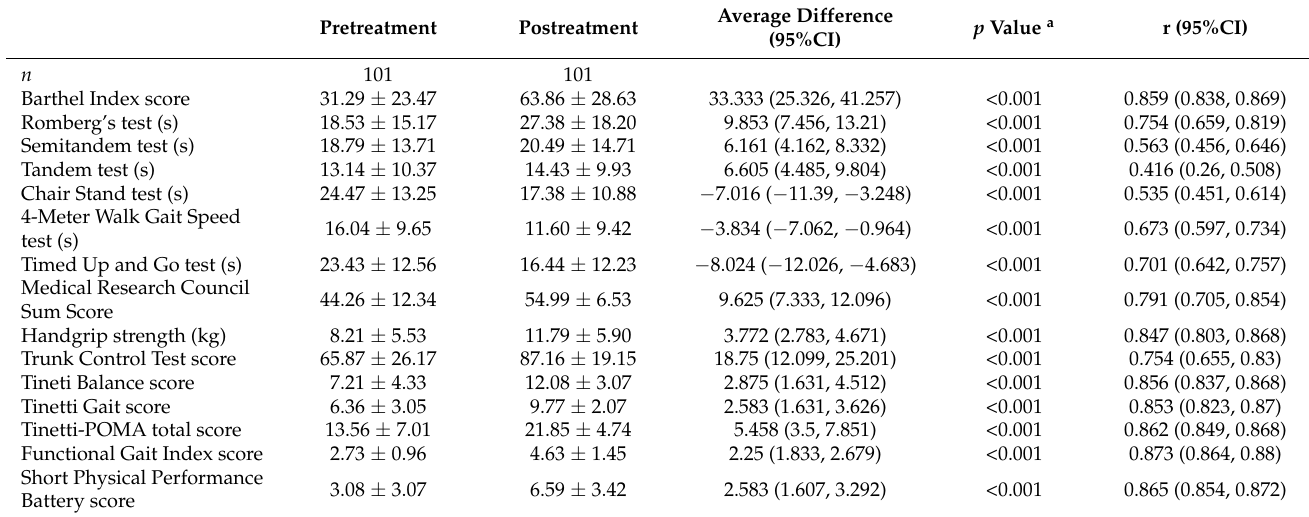
Table 2. Quantitative outcome